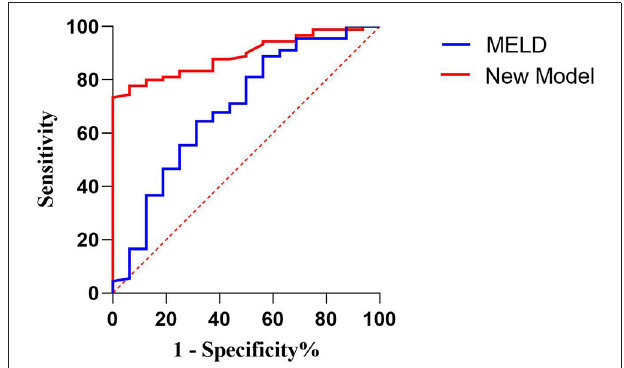
FIGURE 3 | Receiver operating characteristic curve of the model for end-stage liver disease scoring system and the new model for predicting fetal death.